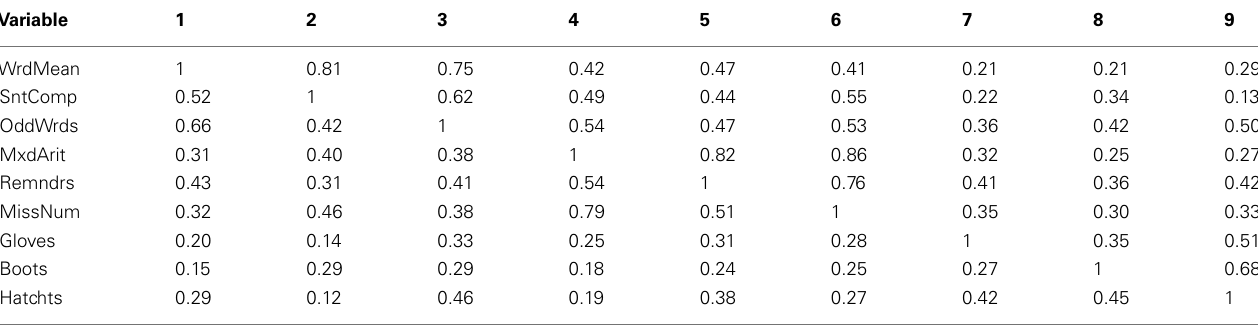
Table 10 | Product-moment and polychoric correlations among Case 4 item-level variables. Variable